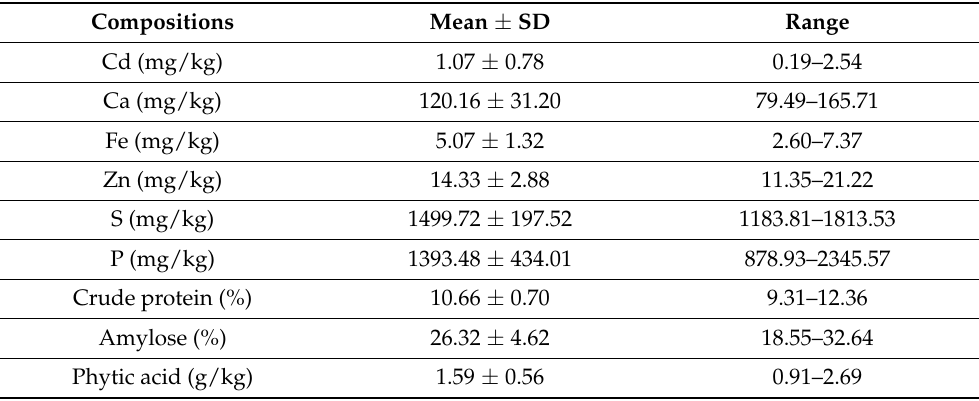
Table 1. Chemical composition analysis of 14 rice